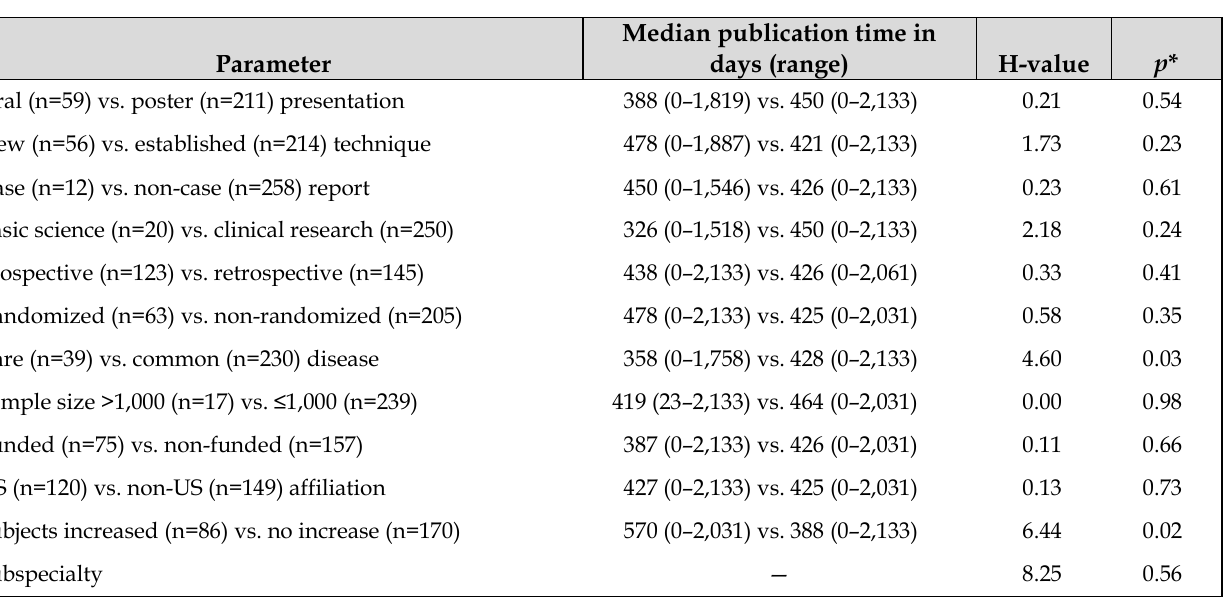
Table 5 Univariate analysis of factors and their publication